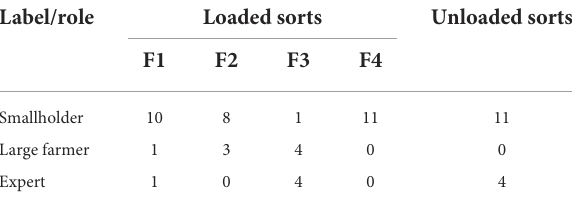
TABLE 7 Overview of the factors’ composition with respect to the predetermined labeling of